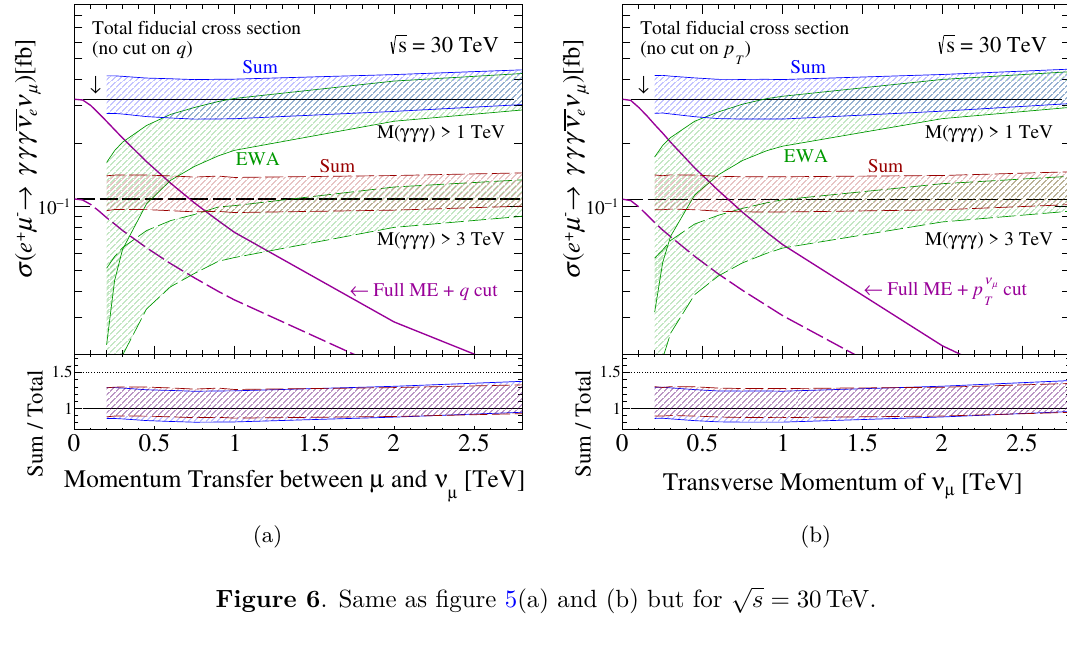
Figure 6 . Same as figure 5(a) and (b) but for